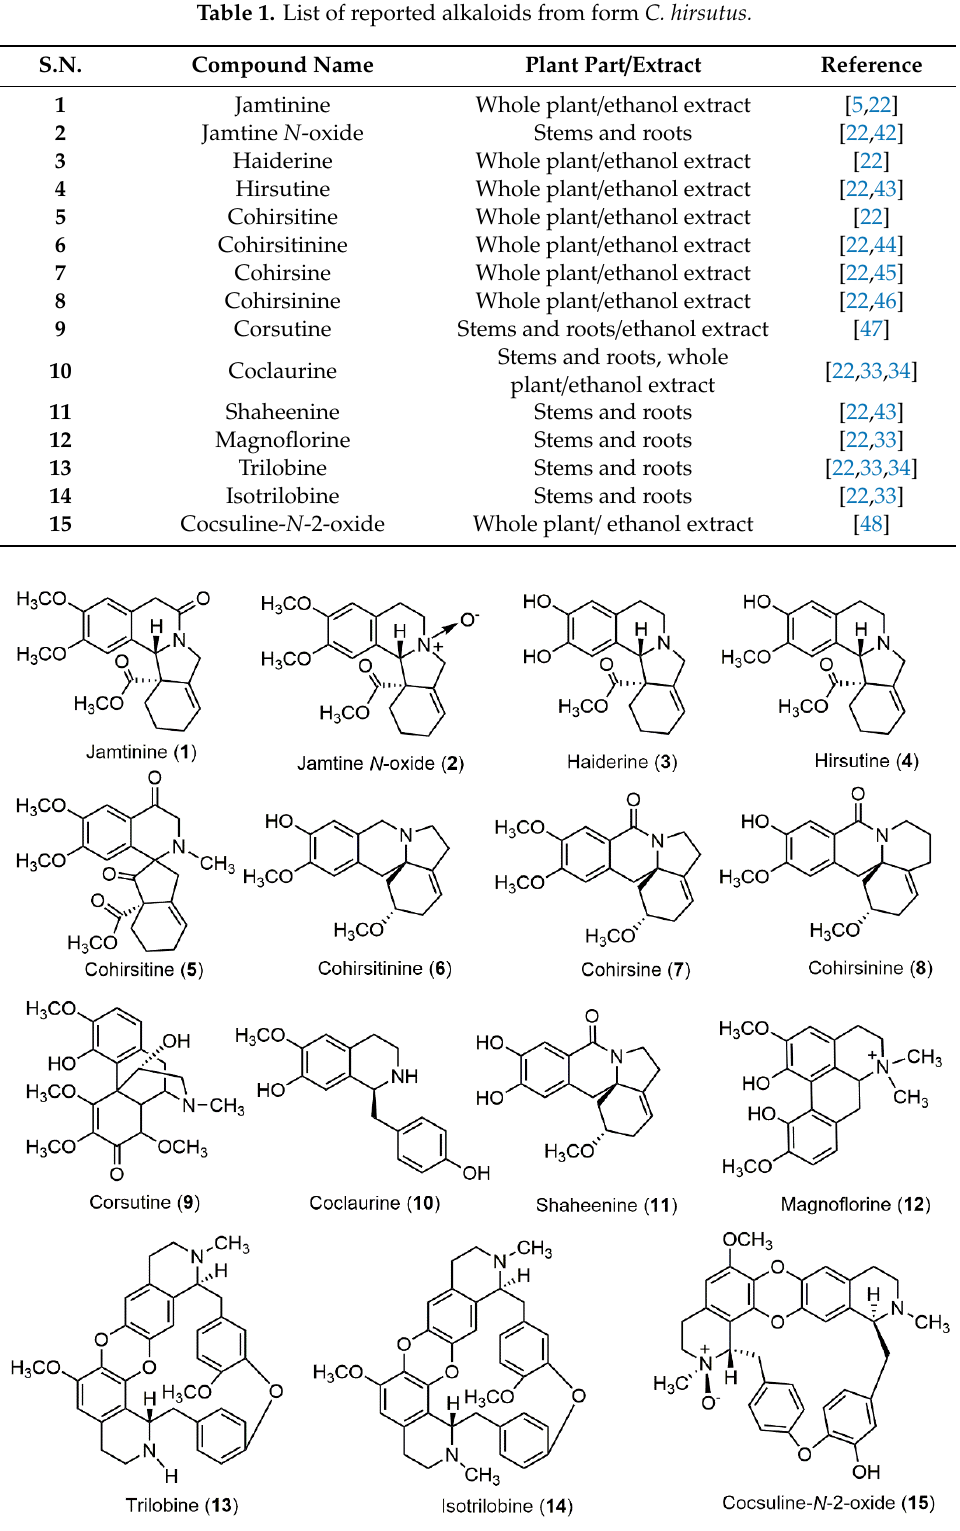
Figure 3. Structures of alkaloids reported from C. hirsutus.